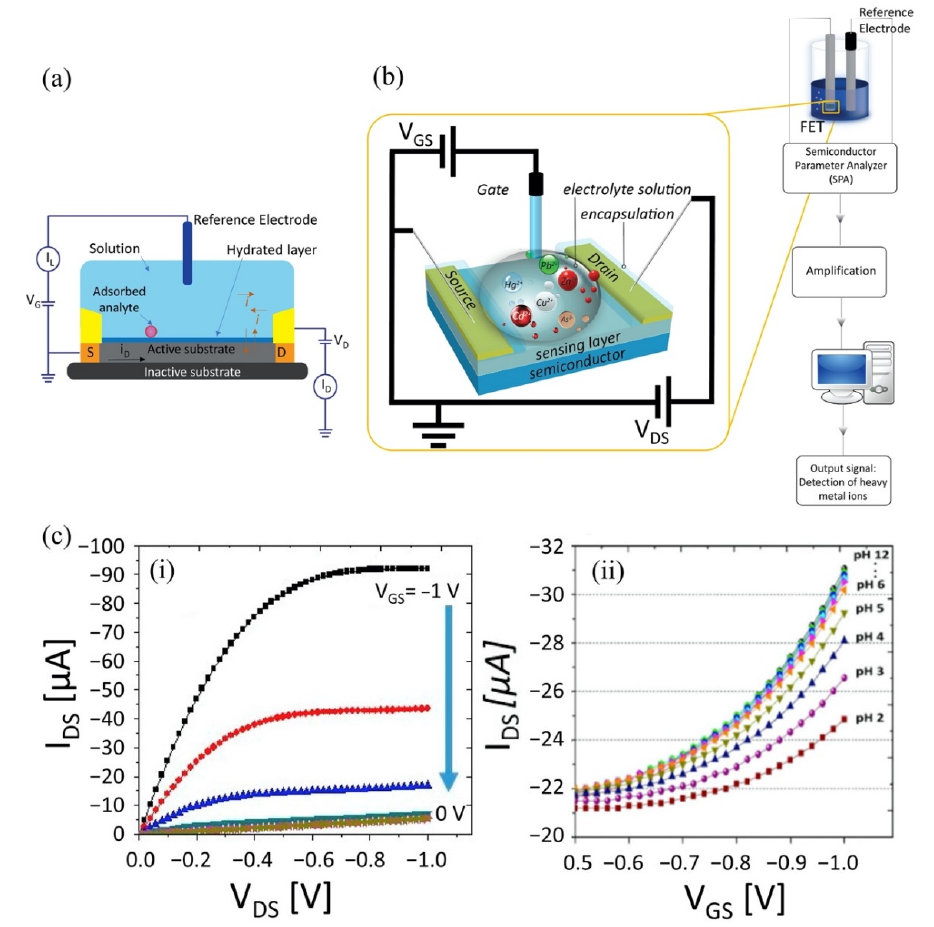
Figure 2 . Schematic of ( a ) cross ‐ section of FET sensor and ( b ) general equipment setup for HMIs electrical detection in Figure 2. Schematic of ( a ) cross-section of FET sensor and ( b ) general equipment setup for HMIs laboratory. ( c ‐ i ) An example of the current ‐ voltage characteristics of a diamond ‐ based SGFET and ( c ‐ ii ) changes in cur ‐ electrical detection in laboratory. ( c - i ) An example of the current-voltage characteristics of a diamond- rent ‐ voltage characteristics of diamond ‐ based SGFET in a wide range of pH solutions (pH 2–pH 12). Reproduced with based SGFET and ( c - ii ) changes in cur-rent-voltage characteristics of diamond-based SGFET in a wide permission from [34]. Copyright 2018 MDPI. range of pH solutions (pH 2–pH 12). Reproduced with permission from [34]. Copyright 2018